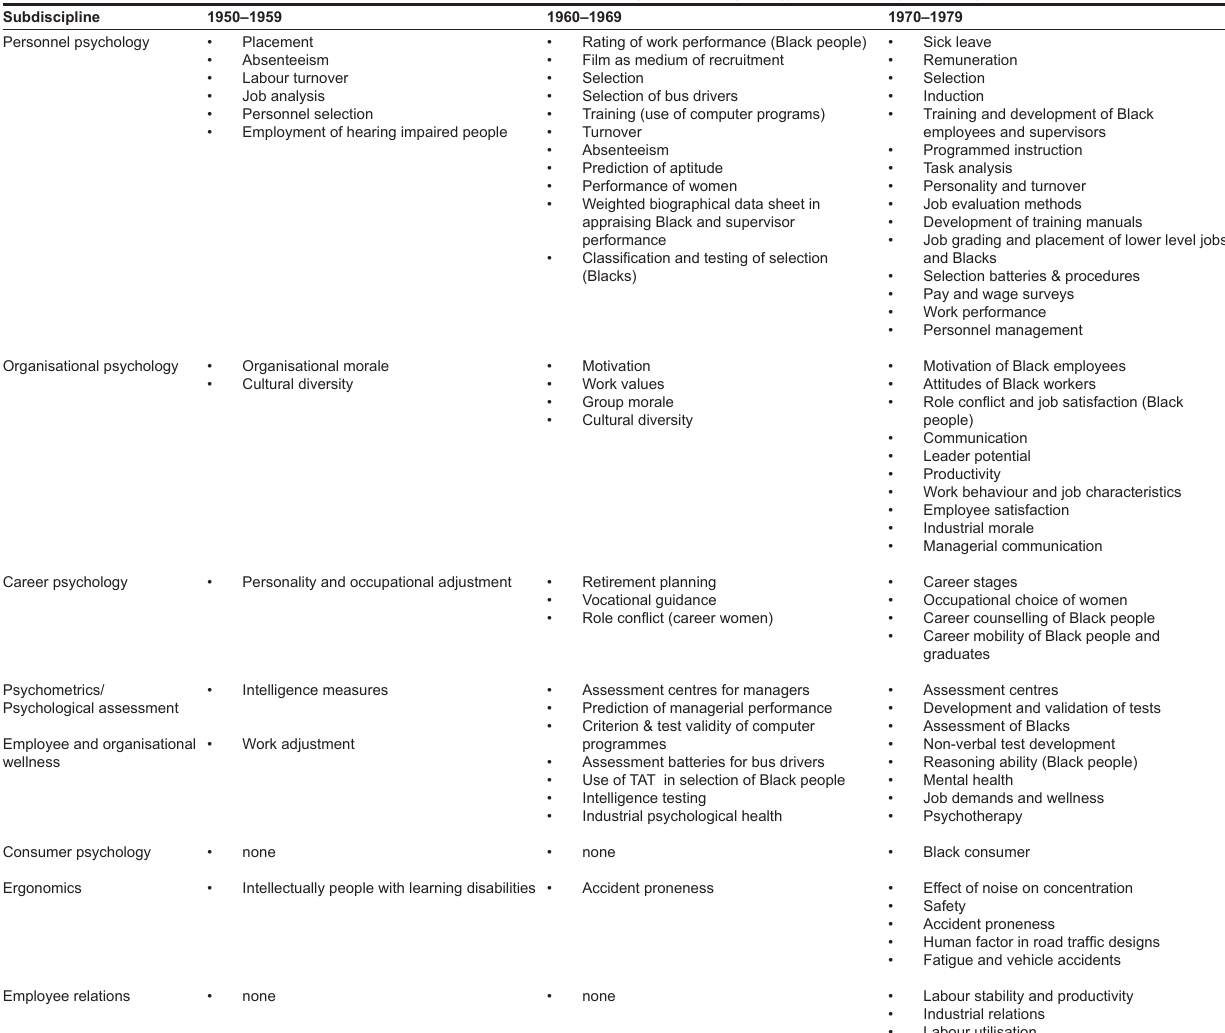
TABLE 3 Dominant research themes in the various Industrial and organisational psychology subdisciplines